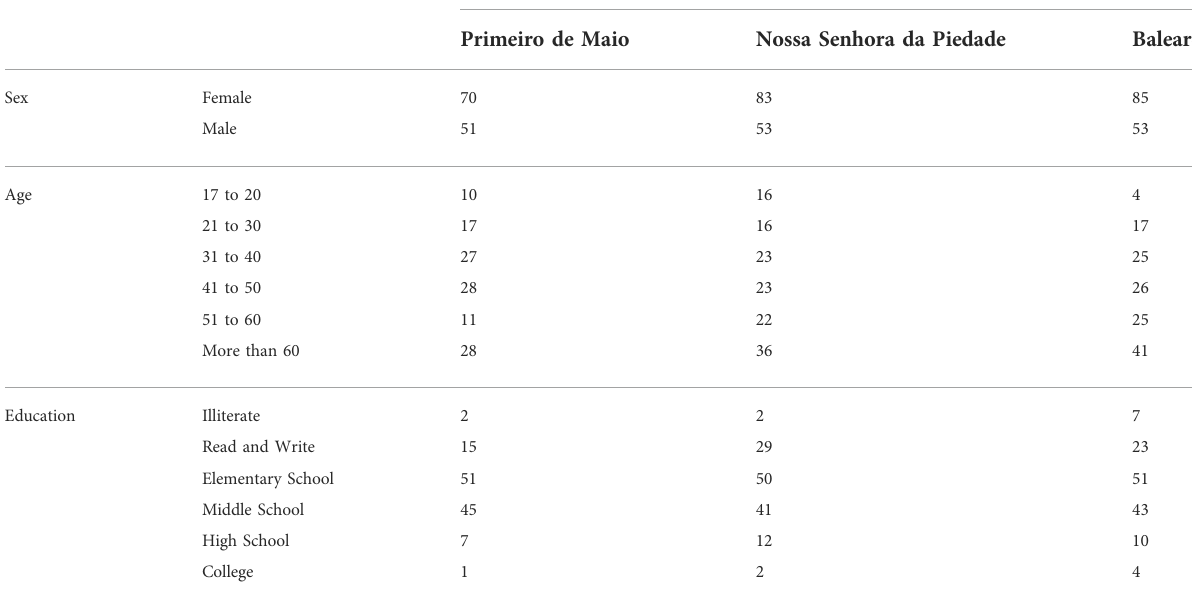
TABLE 4 Sociodemographic pro fi le of population surveyed into 3 rehabilitated riparian parks surroundings. Urban Riparian Park Primeiro de Maio Nossa Senhora da Piedade